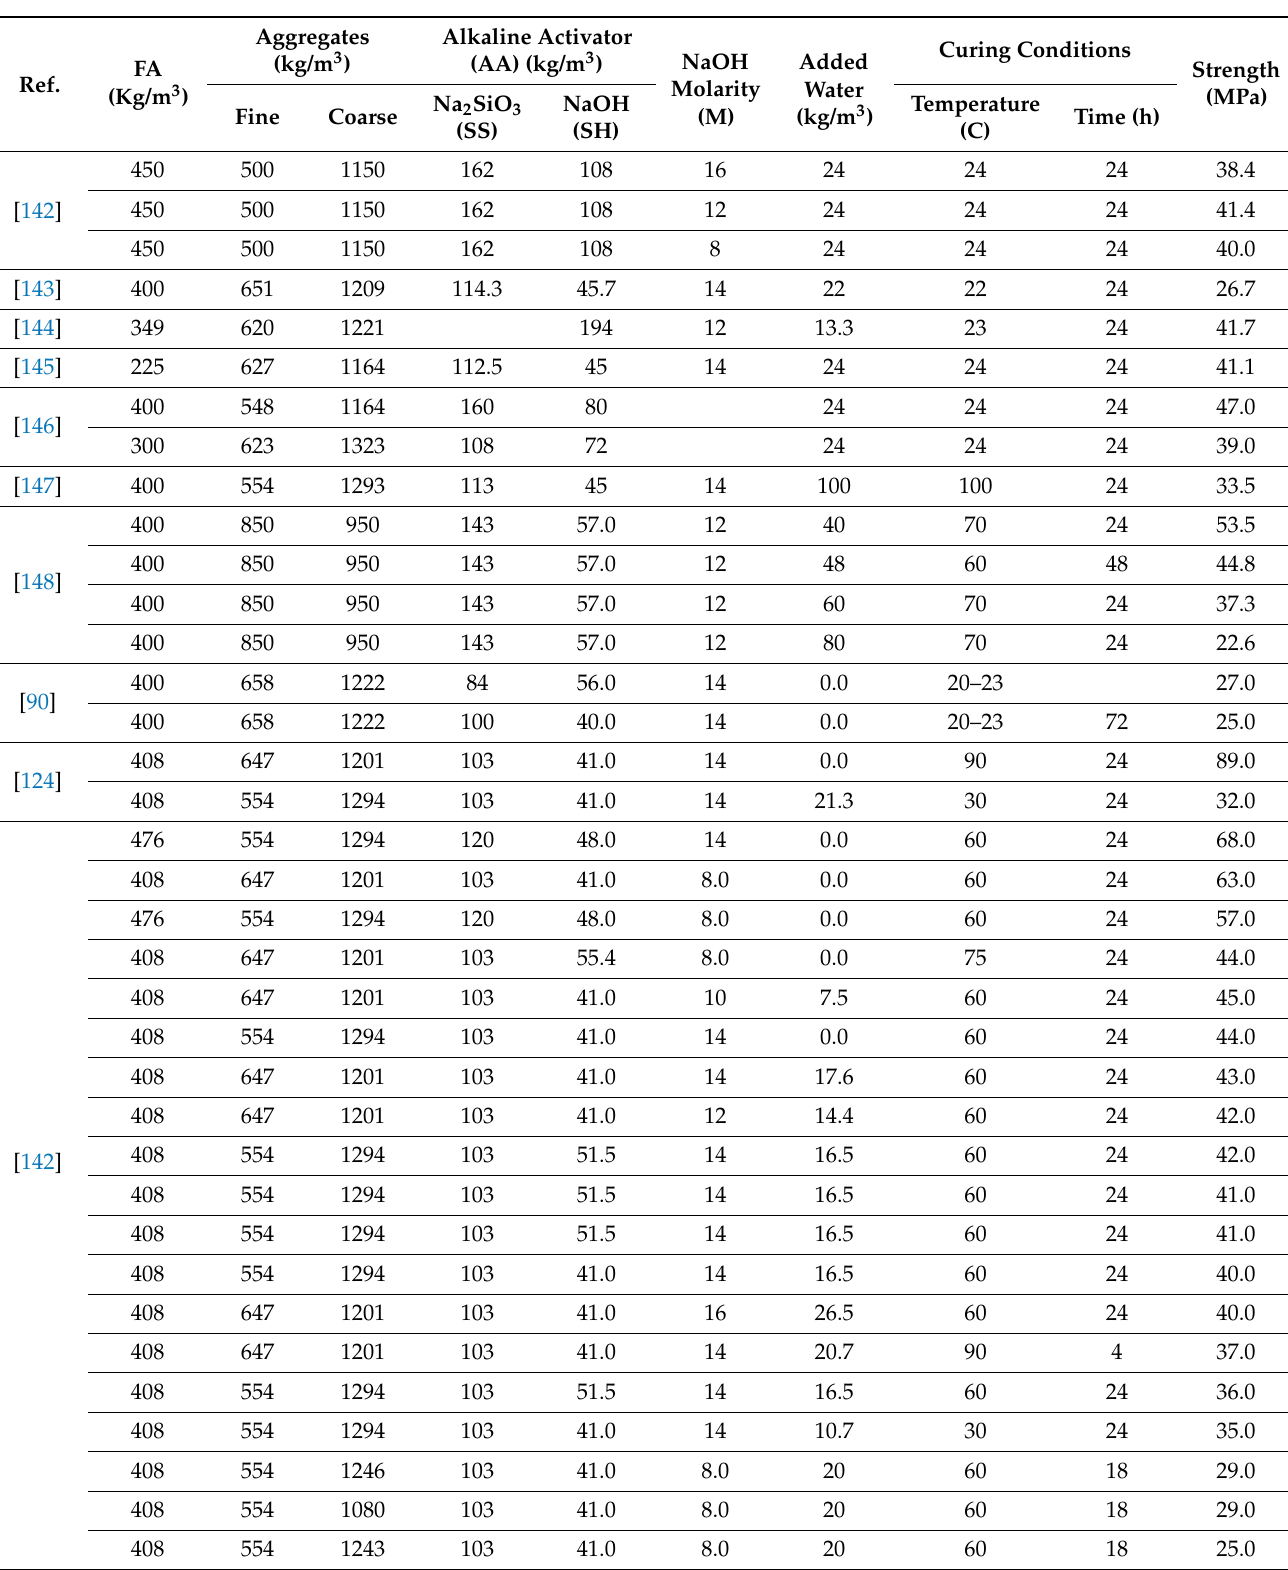
Table 3. Composition of FA-GP